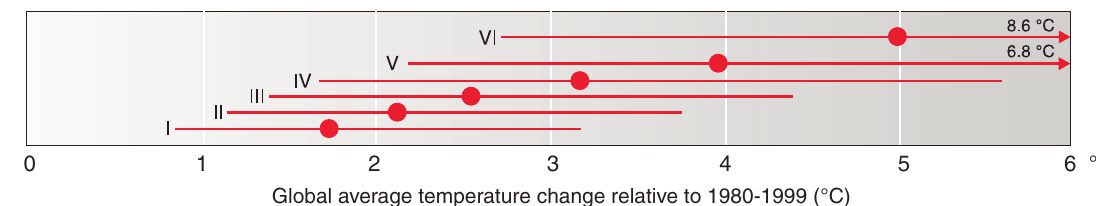
Figure SPM.8. Estimated long-term (multi-century) warming corresponding to the six AR4 Working Group III stabilisation categories (Table SPM.6). The temperature scale has been shifted by -0.5°C compared to Table SPM.6 to account approximately for the warming between pre- industrial and 1980-1999. For most stabilisation levels global average temperature is approaching the equilibrium level over a few centuries. For GHG emissions scenarios that lead to stabilisation at levels comparable to SRES B1 and A1B by 2100 (600 and 850ppm CO and V), assessed models project that about 65 to 70% of the estimated global equilibrium temperature increase, assuming a climate sensitivity of 3°C, would be realised at the time of stabilisation. For the much lower stabilisation scenarios (category I and II, Figure SPM.11), the equilib- rium temperature may be reached earlier. {Figure